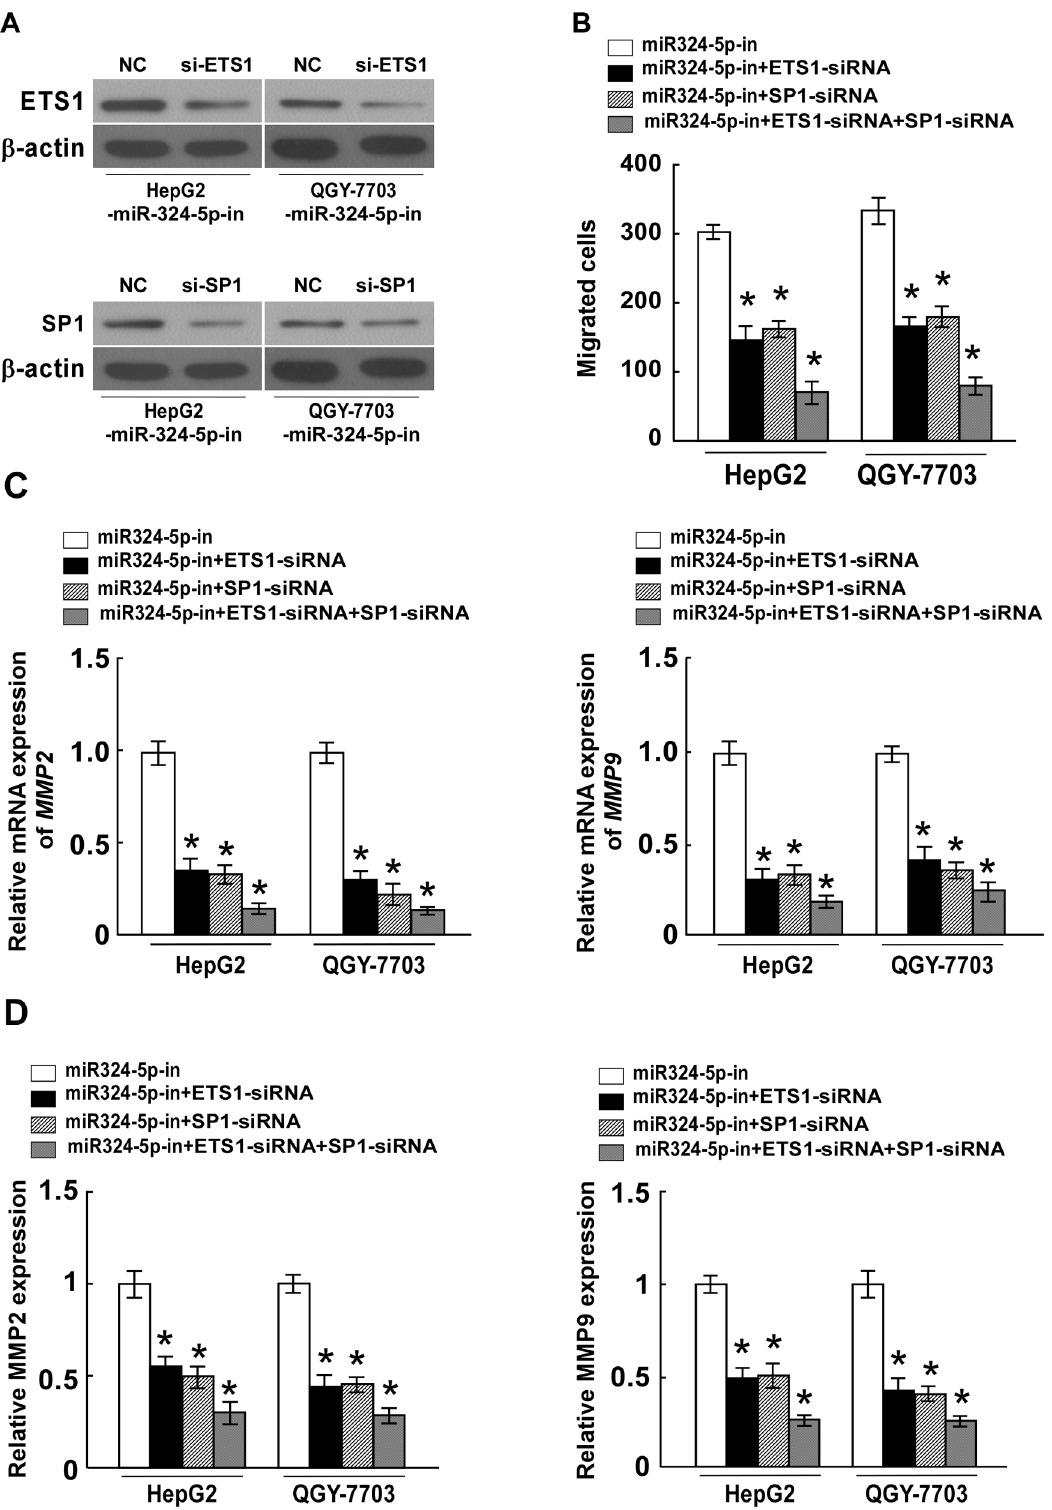
Fig 5. ETS1 and SP1 suppression are essential for miR-324-5p-inhibited cell migration, invasion and ECM degradation in HCC. A. The expression levels of ETS1 or SP1 in miR-324-5p-inhibitor transfected HCC cells that were transfected with ETS1 or SP1-siRNA, as measured by western blotting; α - Tubulin served as the loading control. B. Quantification of indicated invading cells in a Matrigel-coated Transwell assay. C. Real-time PCR analysis of